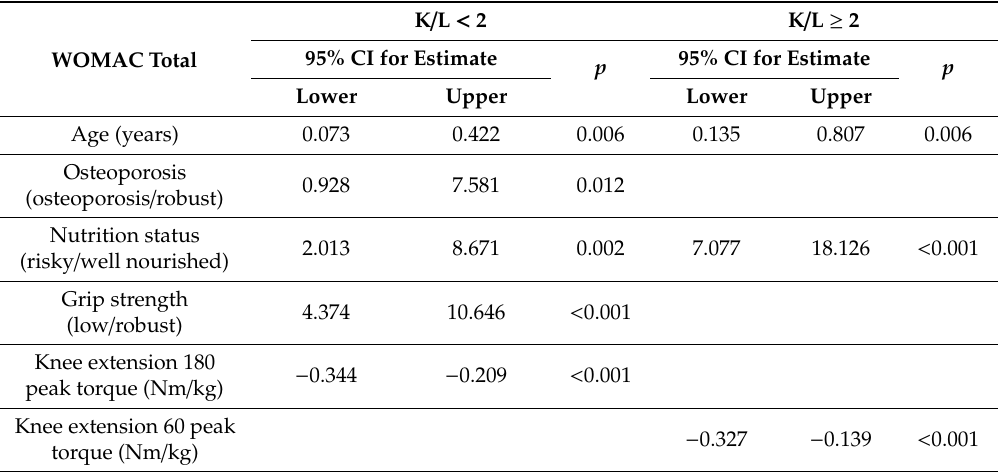
Table 6. Results of stepwise multiple regression analysis for the WOMAC